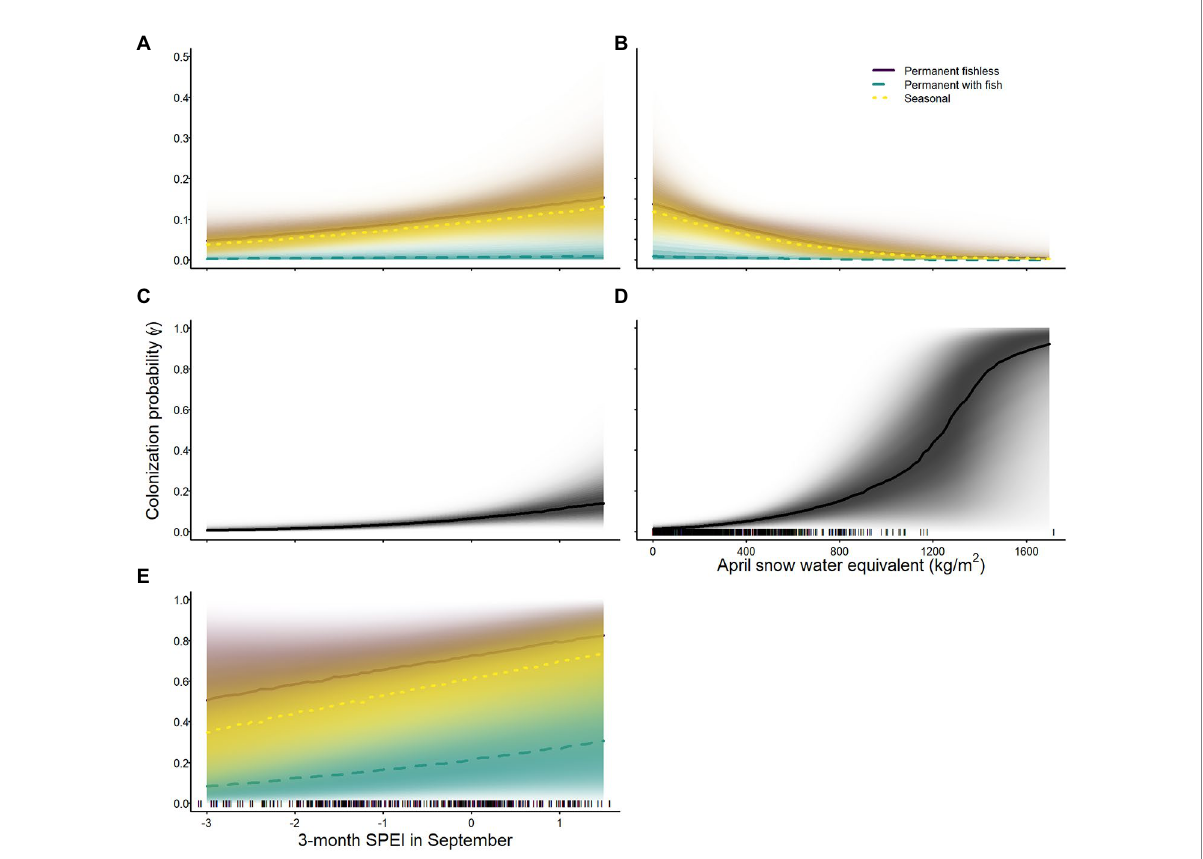
FIGURE 5 Probability of colonization for Sierra Nevada yellow-legged frogs [ Rana sierrae ; (A,B) ], Yosemite toads [ Anaxyrus canorus ; (C,D) ], and sierran treefrogs [ Pseudacris sierra ; (E) ] in relation to 3-month Standardized Precipitation and Evapotranspiration Index (SPEI) in September (A,C,E) , April snow water equivalent (B,D) , and site type (indigo shading and solid line = permanent without fish; aqua shading and dashed line = permanent with fish; gold shading and dotted line = seasonal; black solid lines and shading = no distinction among site types) in Yosemite National Park, California, United States, 2007–2021. Lines represent posterior modes and shading intensity represents the posterior probability